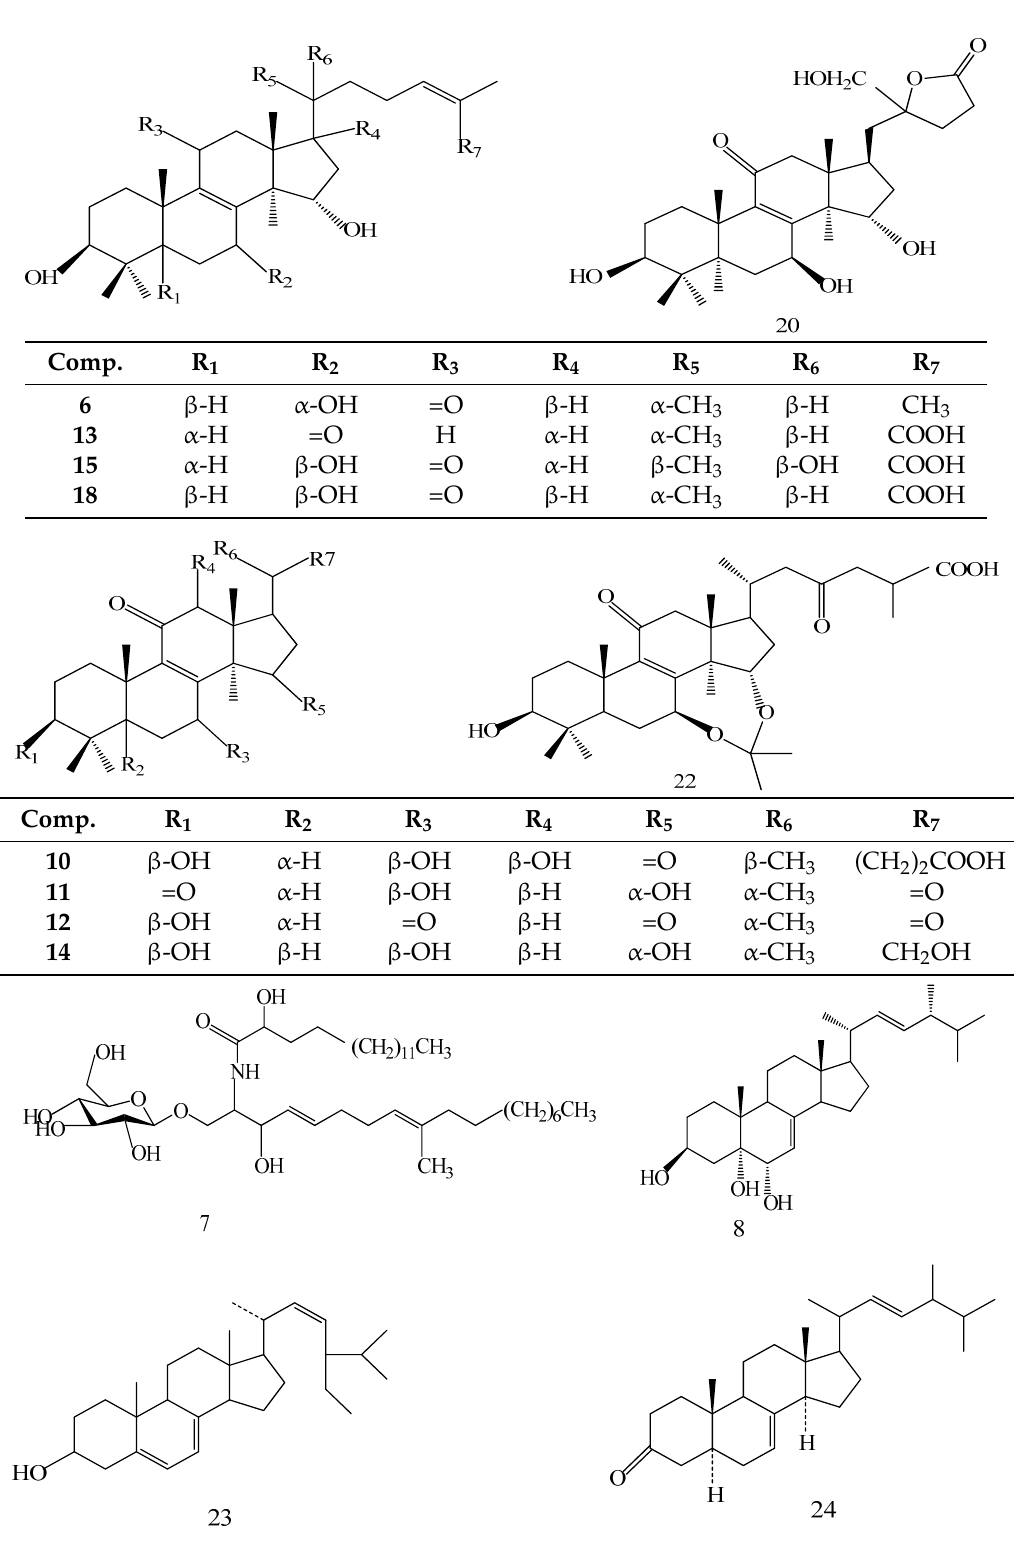
Figure 5. Structures of compounds 1 – 24 .